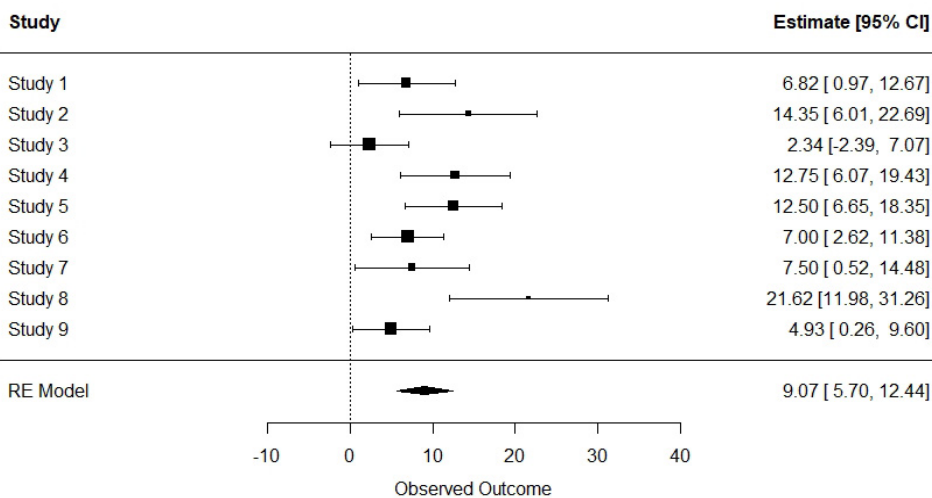
Figure 12. Forest plot evaluating white earhead damage caused by stem borer. For each study, in this figure, a horizontal line indicates the standard effect size of white earhead damage estimate (the rectangular box in the centre of each line) and 95% CL for the risk ratio used. The diamond at the bottom represents the combined estimate of all the studies and its 95% confidence interval (width).